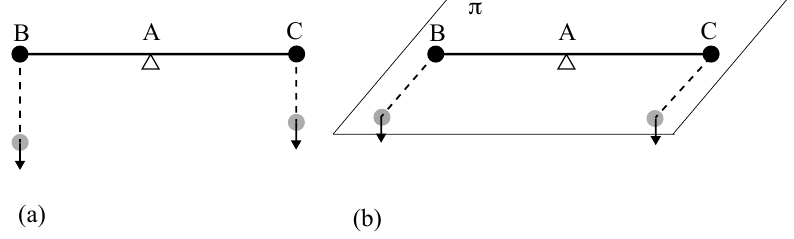
Figure 3. Displacement of weights orthogonal to the beam in a vertical ( a ) and a horizontal ( b )